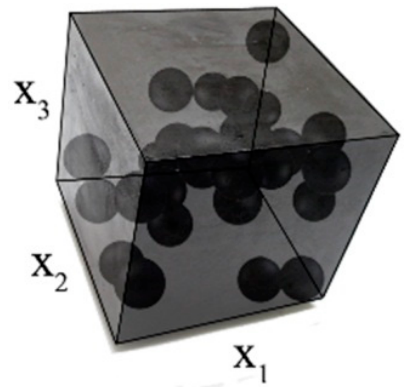
Figure 1. Internal structure of the composite.